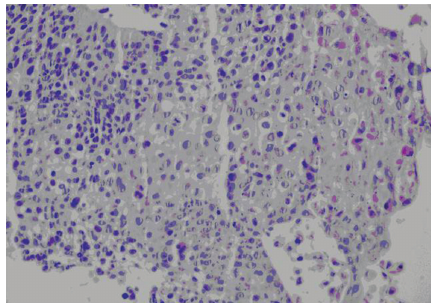
Figure 3: Coarse hyperchromatic atypical cell cluster with an average-width eosinophilic cytoplasm with evident nucleolus (H&E, x40